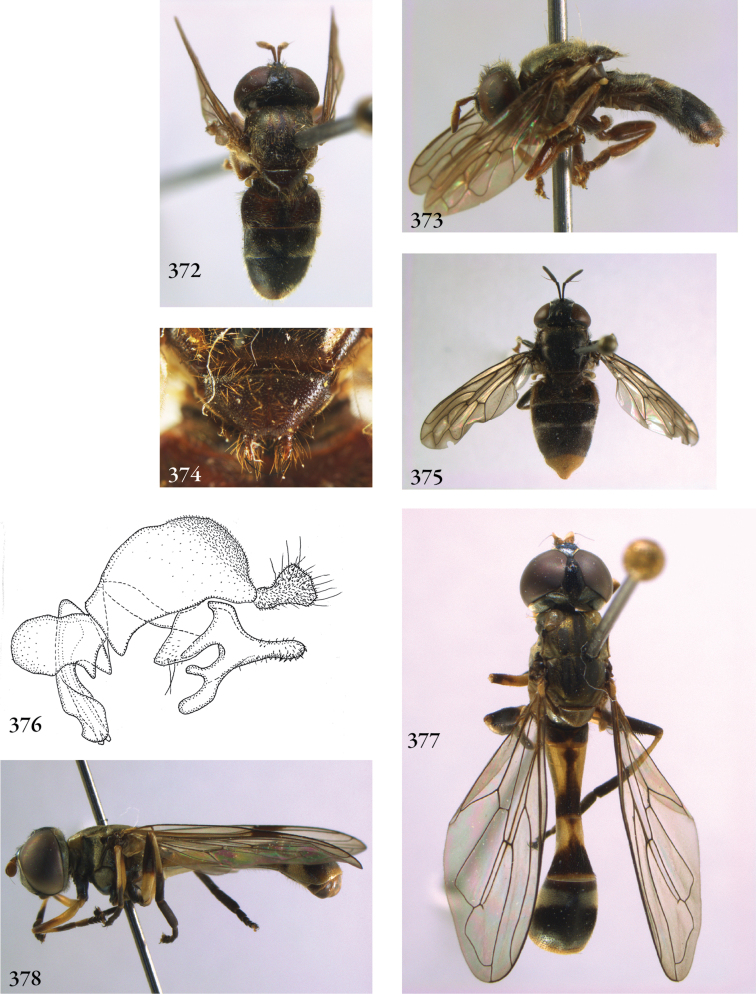
372–373
Serichlamys mitis male (Brazil, coll. RMNH): 372 habitus dorsal 373 habitus lateral 374–375
Serichlamys spec.: 374 male, scutellum (Brazil, coll. RMNH) 375 female, habitus (Ecuador, coll. RBIN) 376
Serichlamys mitis male (Brazil, coll. RMNH), genitalia lateral 377–378
Spheginobaccha macropoda male (Vietnam, coll. RMNH): 377 habitus dorsal 378 habitus lateral